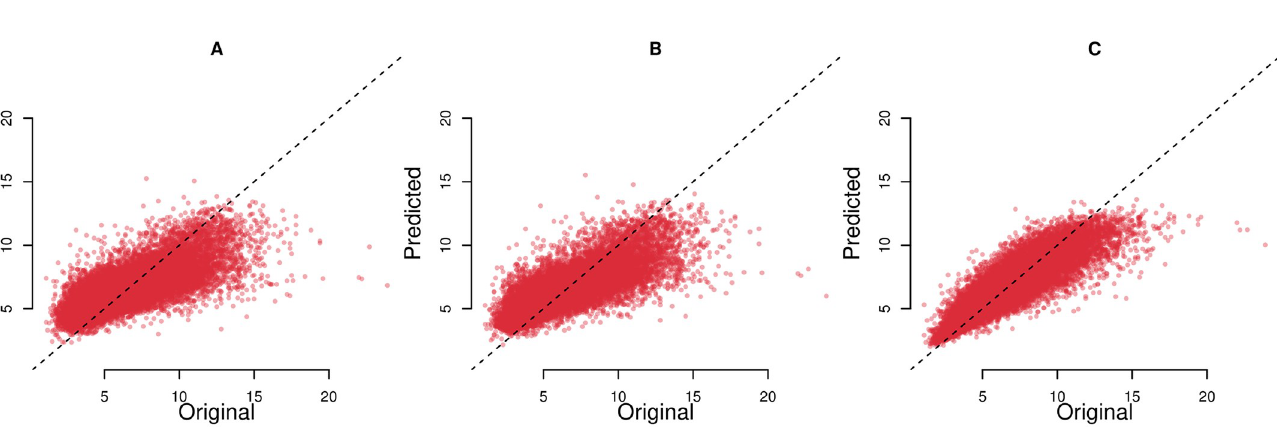
PLOS ONE | https://doi.org/10.1371/journal.pone.0252383 June 9,